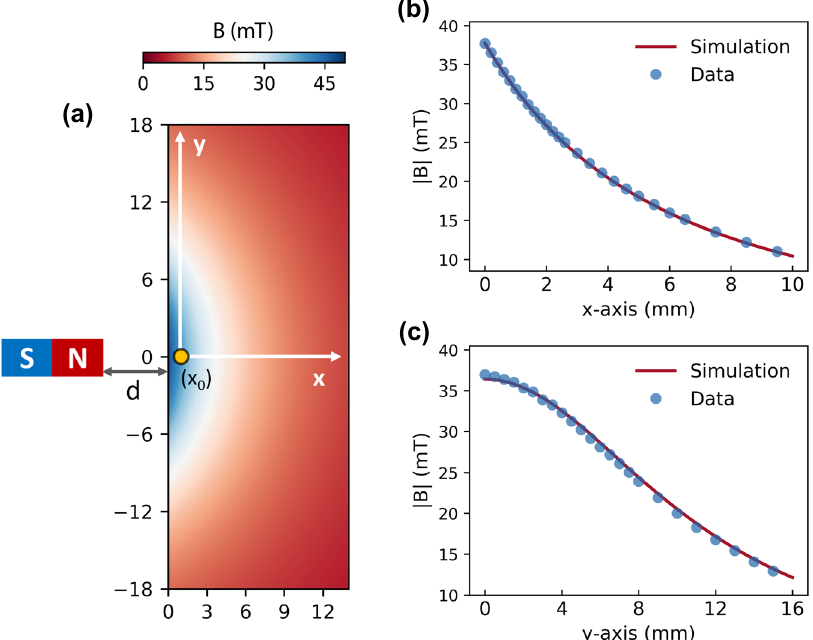
Fig. 2 | EDMR-basedmagnetic fi eld sensing. a Sketch of the experimental set-up (not to scale). A cylindrical magnet is located next to the device with the cylindrical axis of the resulting magnetic fi eld aligned in the plane of the device substrate.2Dsimulationofthespatialdistributionofthedecayingmagnetic fi eld strength generatedby the cylindrical magnet in a regionof 14.0×36.0mm in the x (cid:2) y plane with a distance of d =10.0mm from the magnet. The distance d corresponds to the half size of the device substrate width as the OLED is located at the center of the rectangular glass substrate (see Supplementary Fig. 7). In actualexperiments,weinitiallysetatinygap( x 0 )betweenthesubstrateedgeand the magnet at the starting position to avoid possible physical contact between